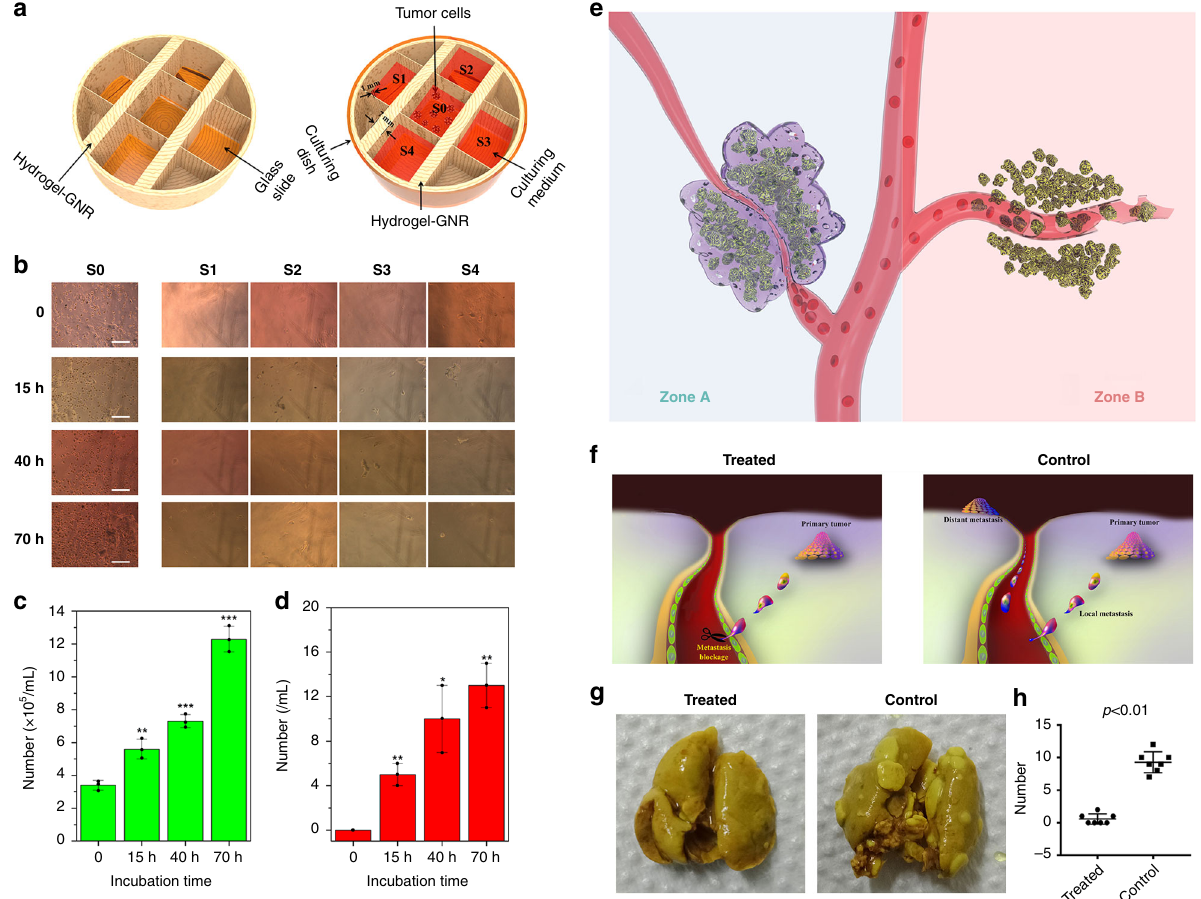
Fig. 8 Evaluations on inhibited tumor metastasis using this starvation therapy. a In vitro anti-metastasis apparatus schematic that is used to evaluate the ability of hydrogel – GNR to occluding the migration passage of cell invasion, wherein S0 is the primary site of PANC-1 tumor cells, and S1 – S4 represent four objective metastasis sites and are separated from S0 with hydrogel – GNR with varied thicknesses. b Optical microscopic images of S0 – S4 after different incubation periods (scale bar: 200 µ m). c , d The number of time-dependent cells in S0 ( c ) and S1 – S4 ( d ). * P < 0.05, ** P < 0.01, and *** P < 0.001,